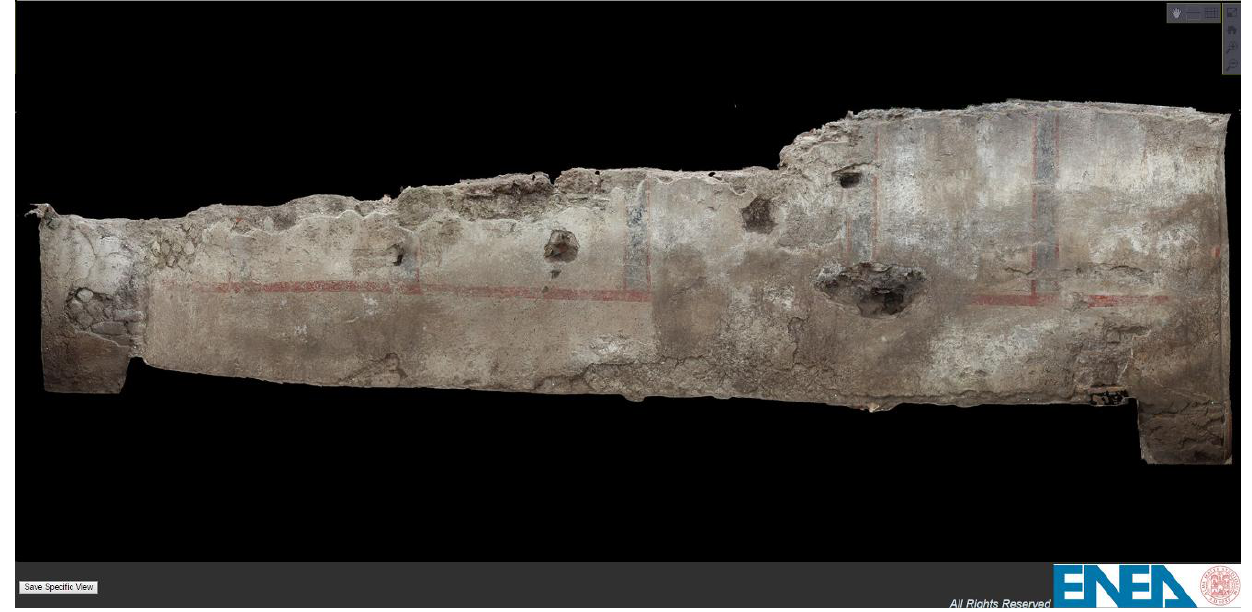
Fig. 10. 3D High Resolution